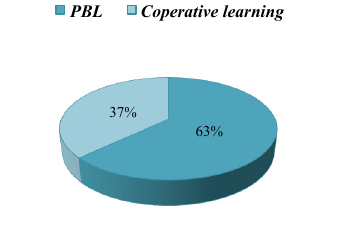
Figure 4. Meaningful learning methods: PBL versus CL.